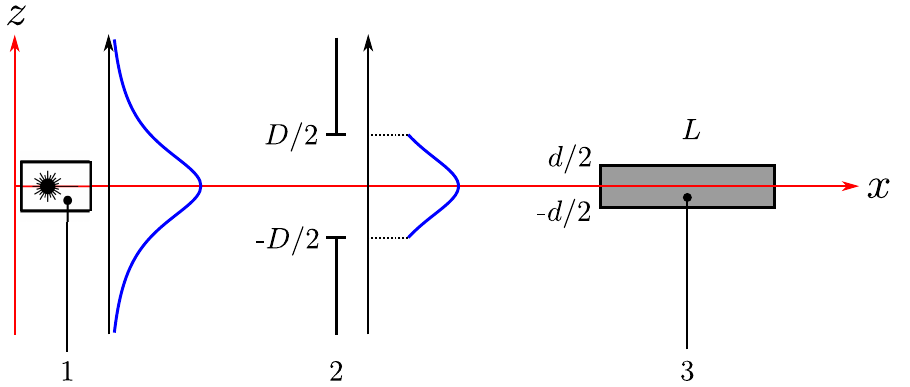
Figure 2. Schematic of acousto-optic Bragg diffraction: 1—THz laser; 2—optical window of AO cell; 3—region of AO